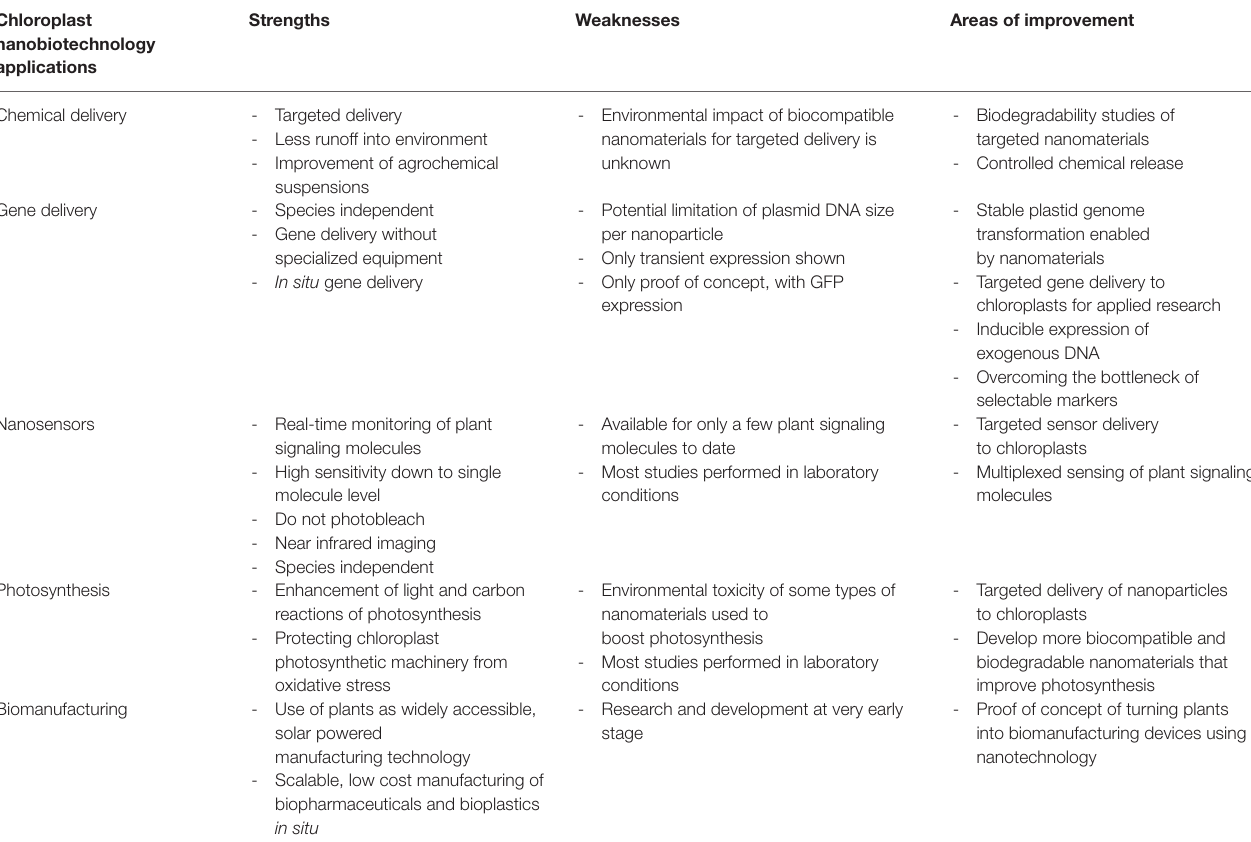
TABLE 1 | Strengths and weaknesses of nanotechnology approaches for chloroplast biotechnology advancements. Chloroplast